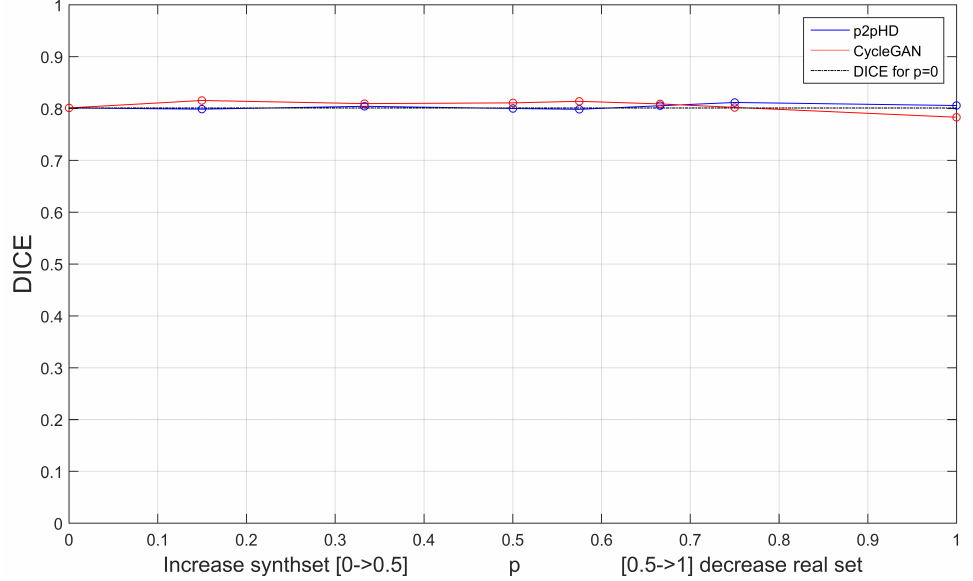
Figure 9. Effects of augmentation ( p = 0